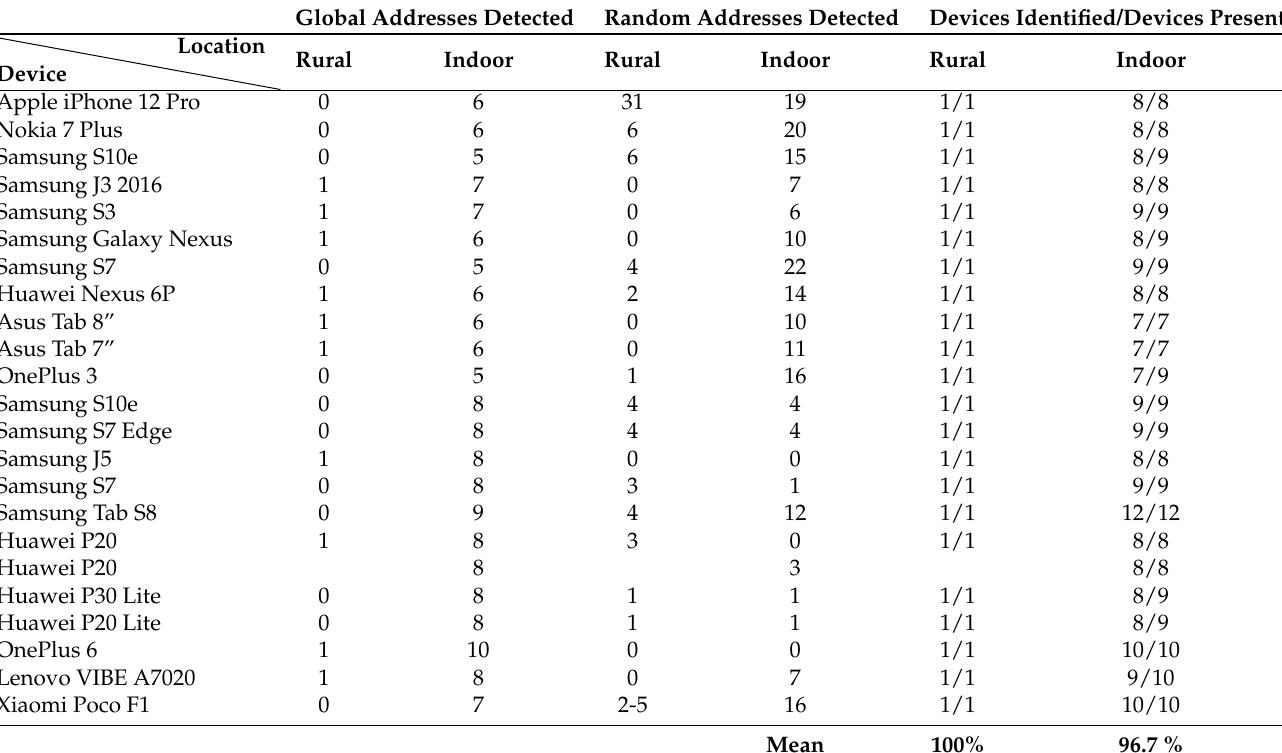
Table 4. MAC de-randomization results for individual devices for the rural and indoor environments.